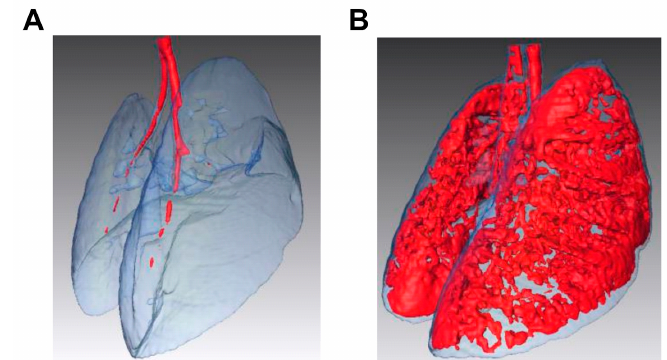
Figure 4. Micro-computed tomography (CT) assessment of elastase-induced chronic obstructive pulmonary disease model mice treated with porcine pancreatic elastase (PPE) using the negative pressure method. Three-dimensional images were obtained by integrating CT images of the mice treated with ( A ) 0 units of PPE (i.e., with saline alone) or ( B ) with 7.5 units of PPE. The low attenuation area (from − 871 to − 610 Hounsfield units (HU)) is colored in red, and the whole lung field (from − 1000 to − 200 HU) is colored in blue.